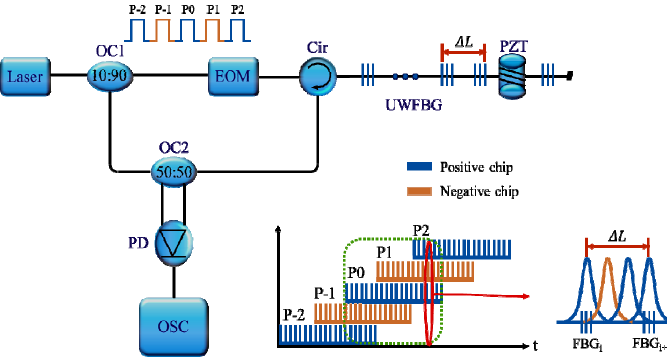
Fig. 16 Multiple times measurement bandwidth improvement through coherent detection Φ -OTDR